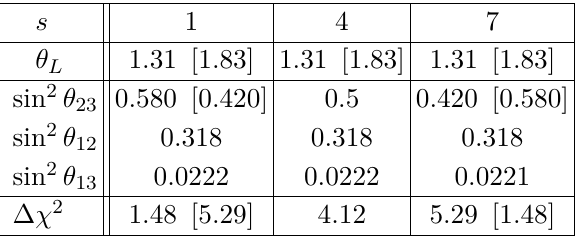
is indicated in L